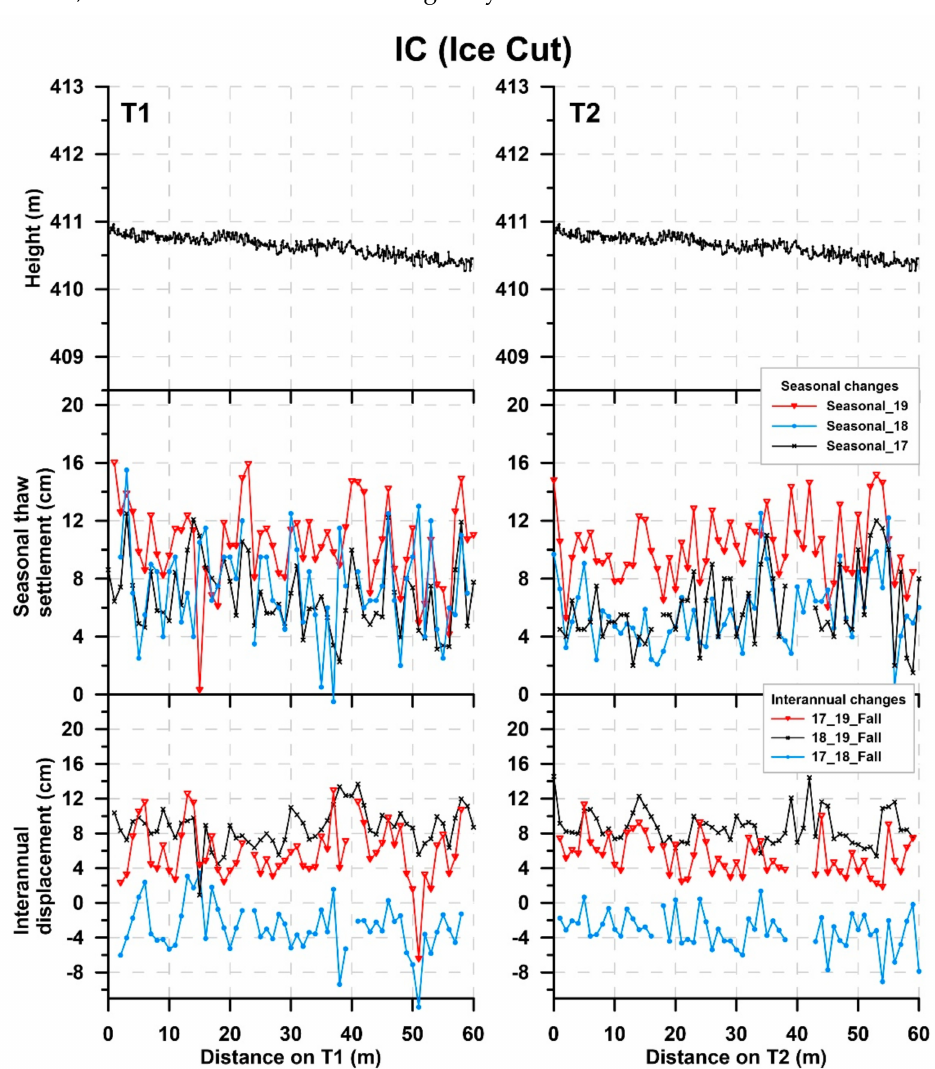
Figure 7. Microtopography in ellipsoid height (top), seasonal thaw settlement (middle), and in- terannual displacement at site IC. The heights of ground surface at survey stakes were measured on 29–30 May and 17–18 August in 2017, 2–3 June and 10–11 September in 2018, and 30 May and 20 August in 2019. Legends for the plots are the same as in Figure